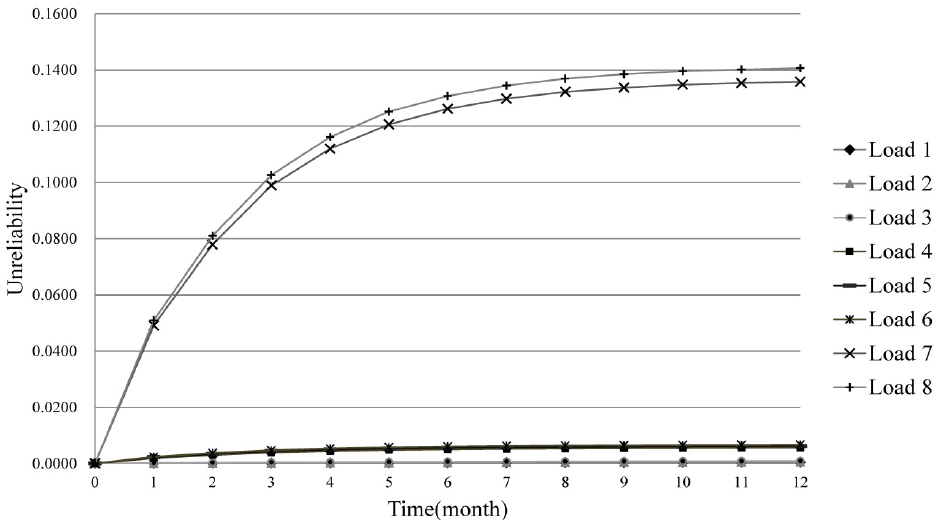
Figure 8. Unreliability curves in a year of different loads in the local framework.